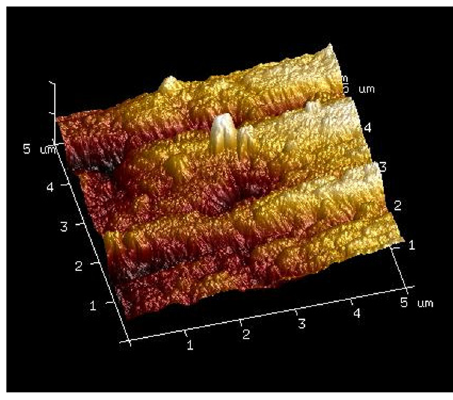
Figure 2: Micro - morphology of textured tools surface ( 100 nm ) .